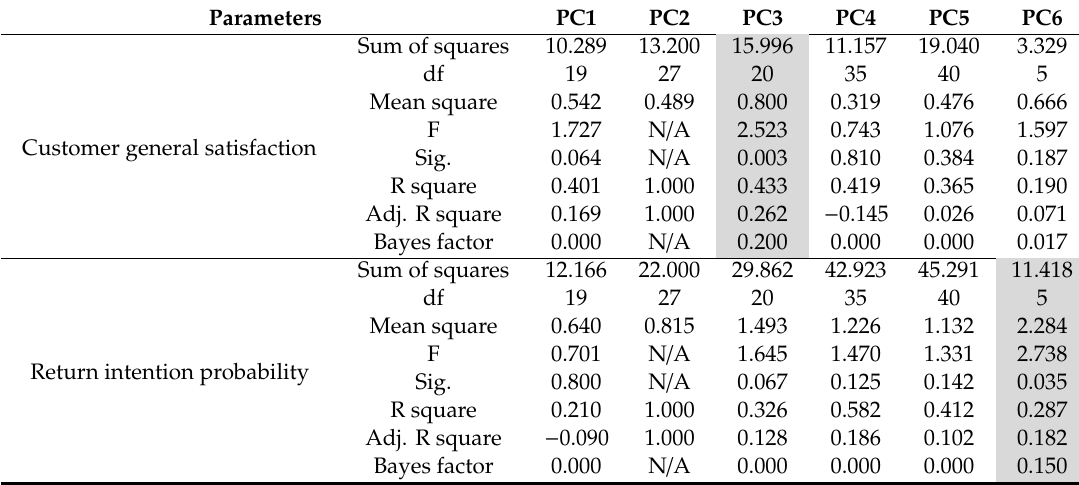
Table 4. Bayes factor model summary of model testing for customer general satisfaction and return intention probability in regards to camel tourist